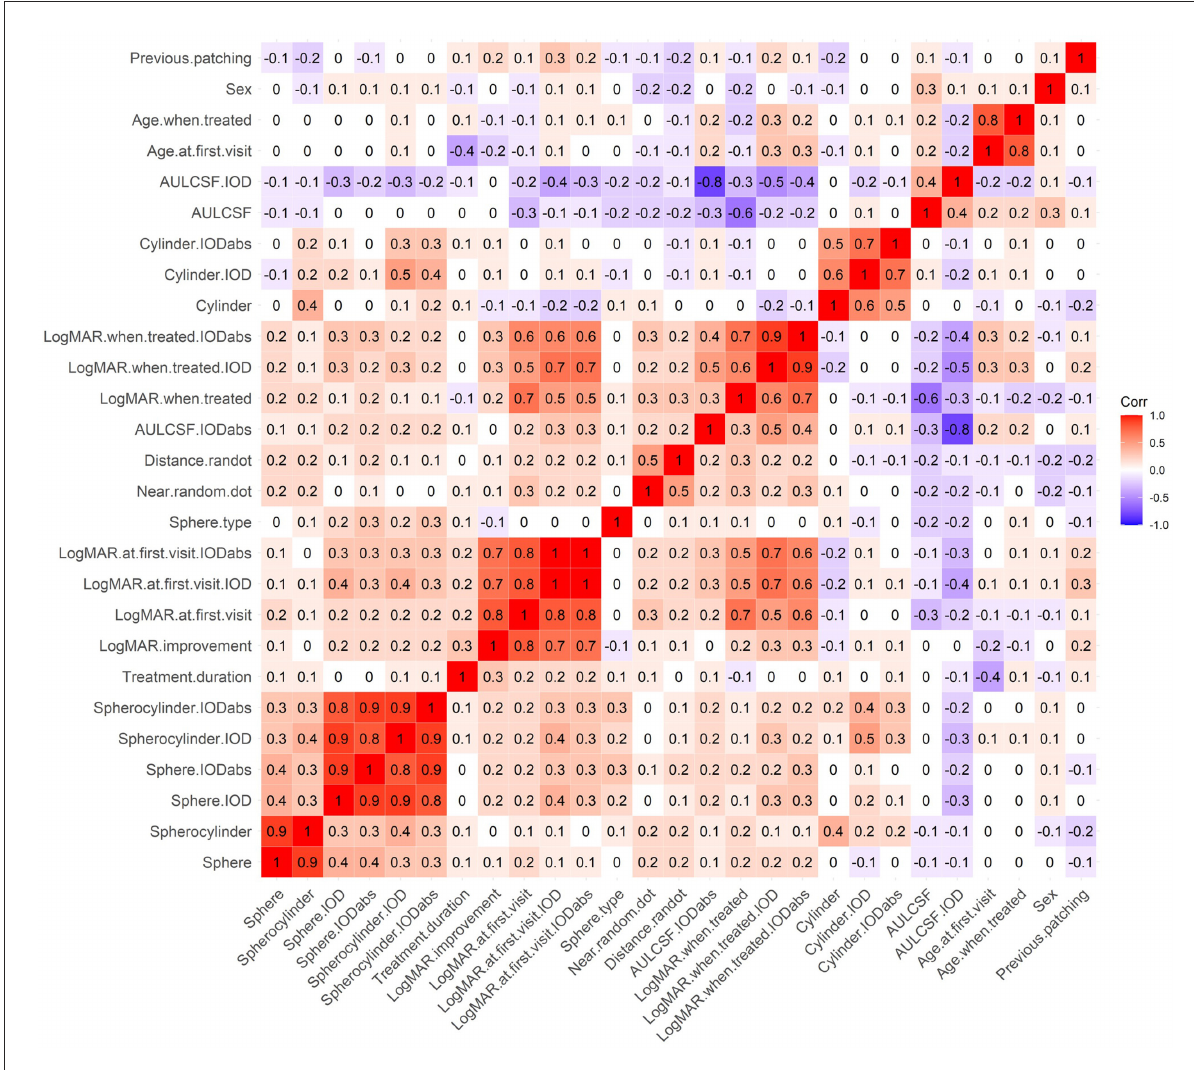
FIGURE2 A correlation heatmap of predictor variables. Red represents positive correlations and purple represents negative